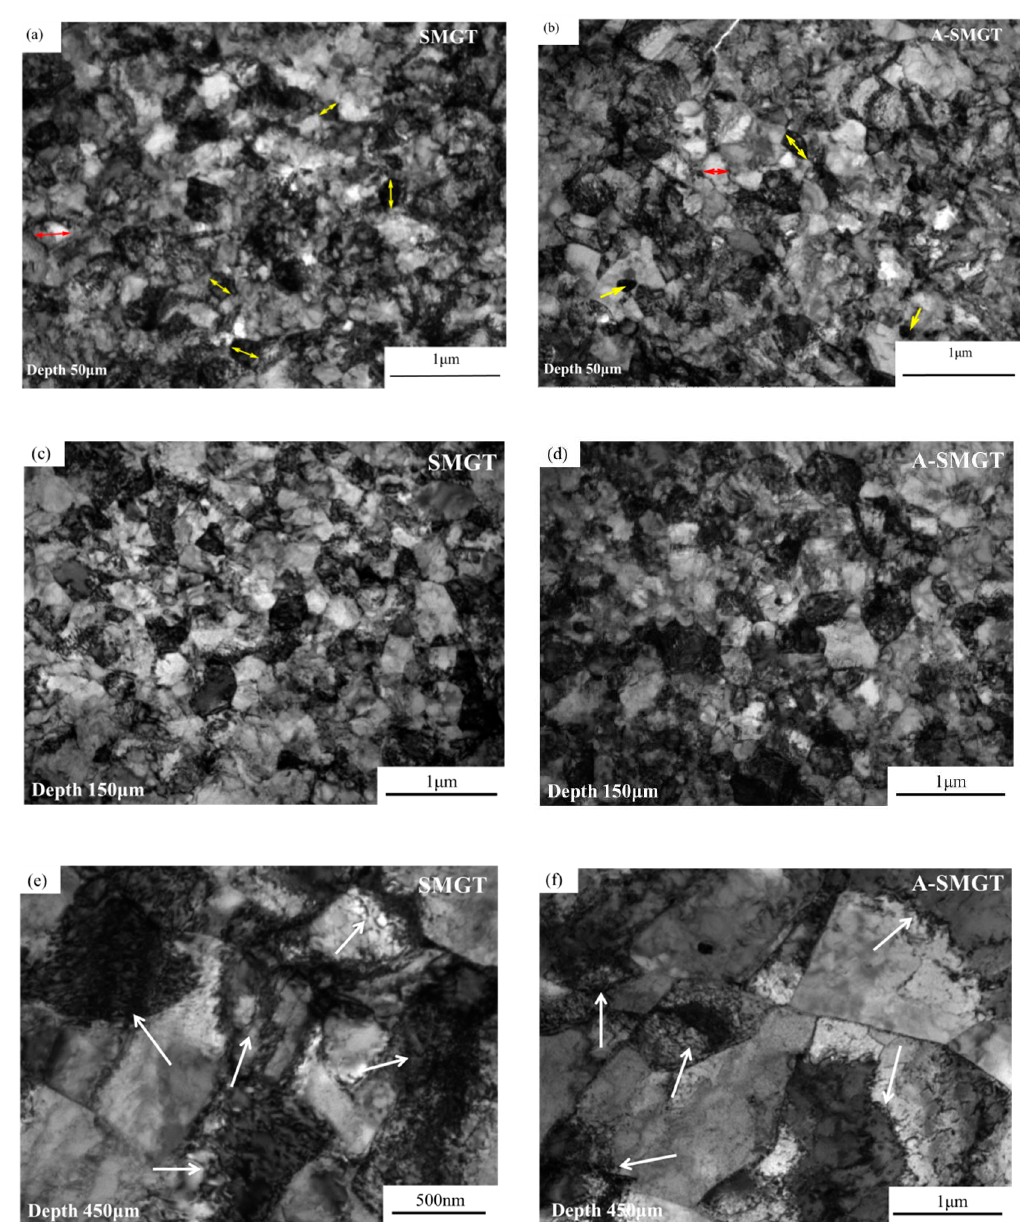
Figure 3. Microstructures of different depths from the surface of SMGTed Zr-4 samples and A-SMGTed Zr-4 samples, SMGTed: ( a , c , e ) and A-SMGTed ( b , d , f ). The arrows in ( a ) and ( b ) indicate the ultra-fined grains.